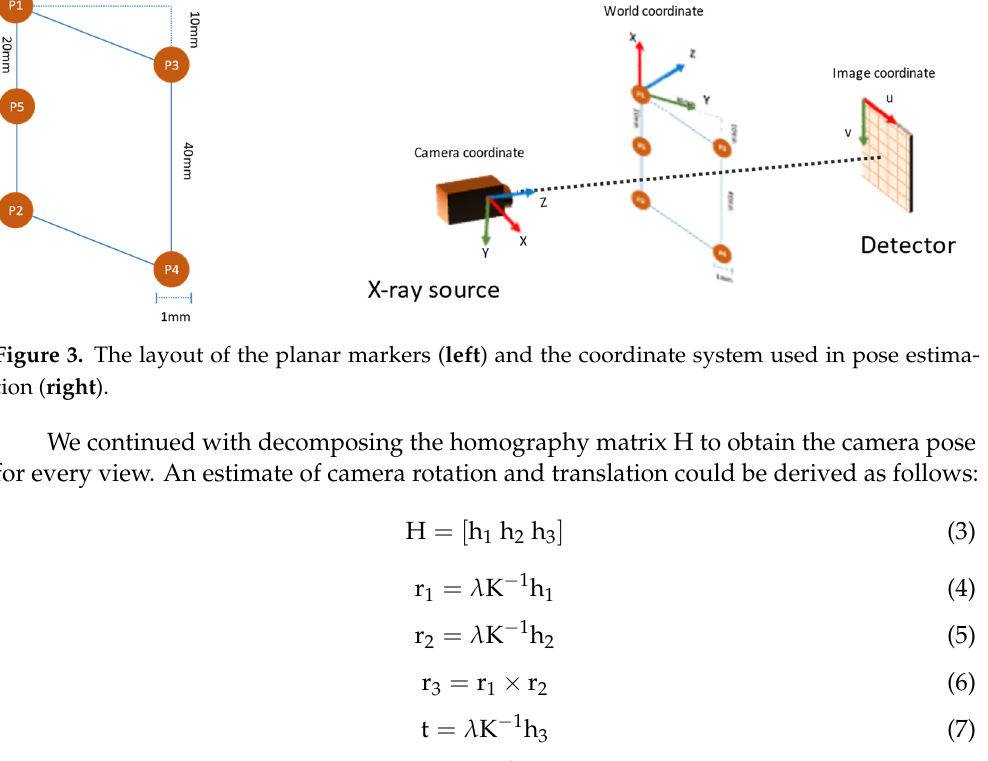
Figure 2. The layout of the checkerboard. The detectable image feature points are marked in red circles.